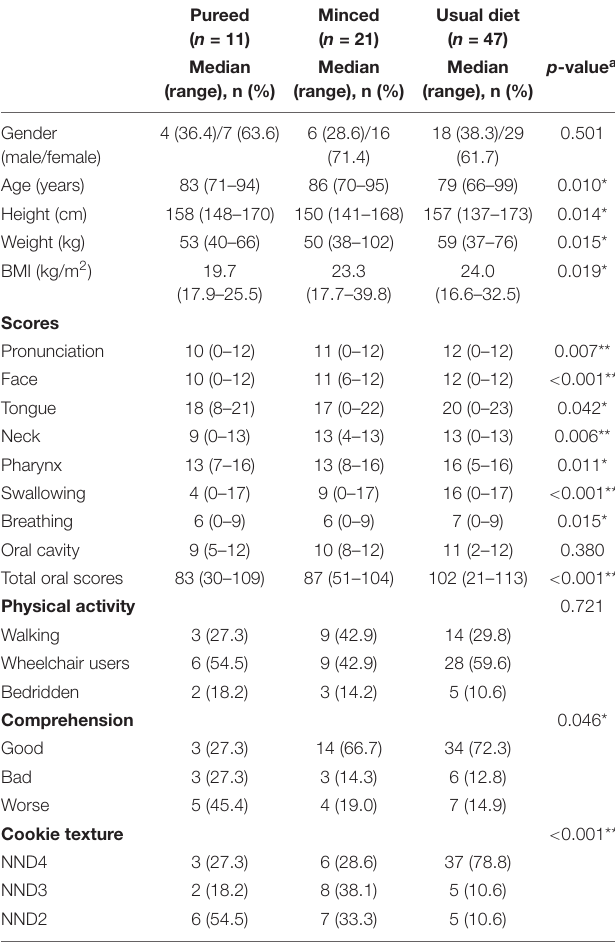
TABLE 1 | Characteristics of subjects in a nursing house ( N =